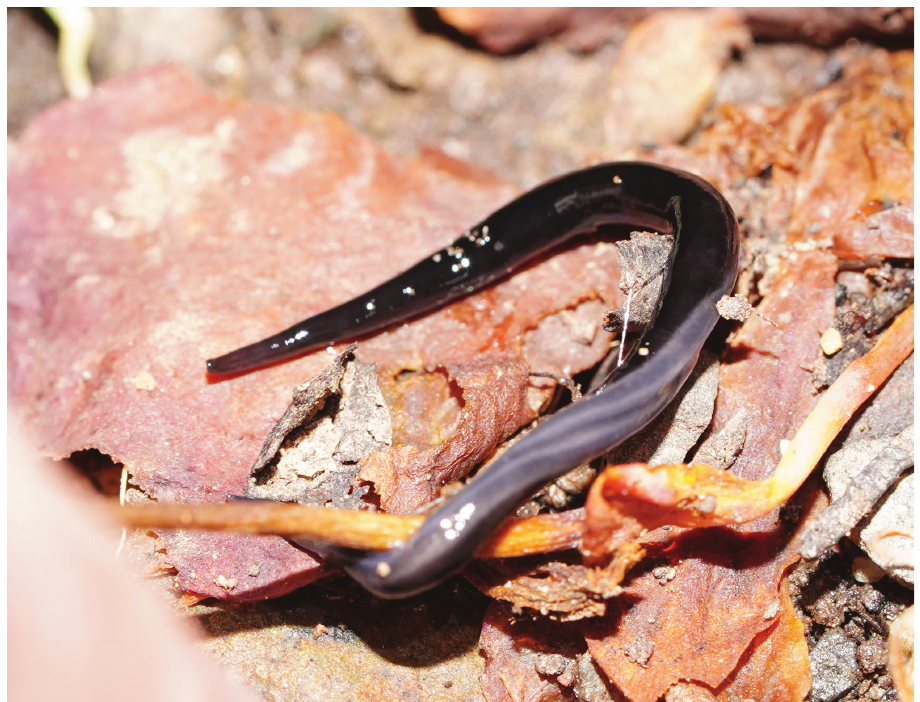
Figure 1. Living flatworm Australopacifica atrata (Steel, 1897), showing underside of mid